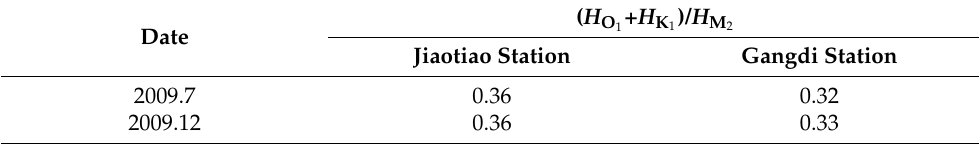
Table 2. Tidal eigenvalue ( H O